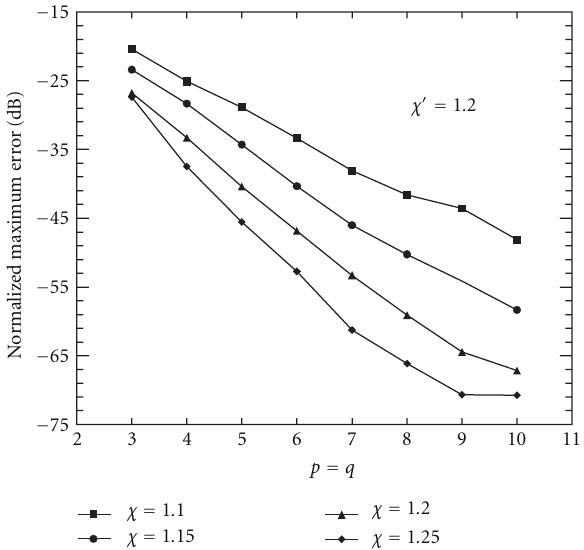
Figure 7: Normalized maximum errors in the reconstruction of the voltage V (cid:2) .